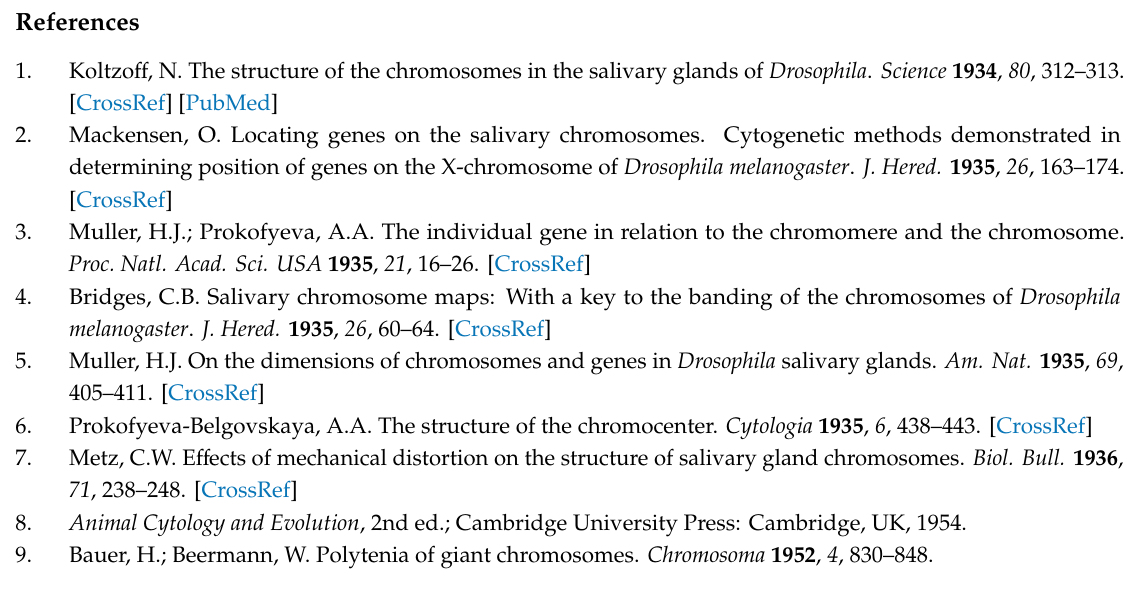
Figure S1: Detailed molecular-genetic description for the 3C1–3C7 region. (A) scale and bands localization according to FlyBase; (B) bands (horizontal black bars) and interbands (vertical blue lines) localization according to the present study; (C) genes location (RefSeq); (D) probes location in kirre ; (E) chromatin states models